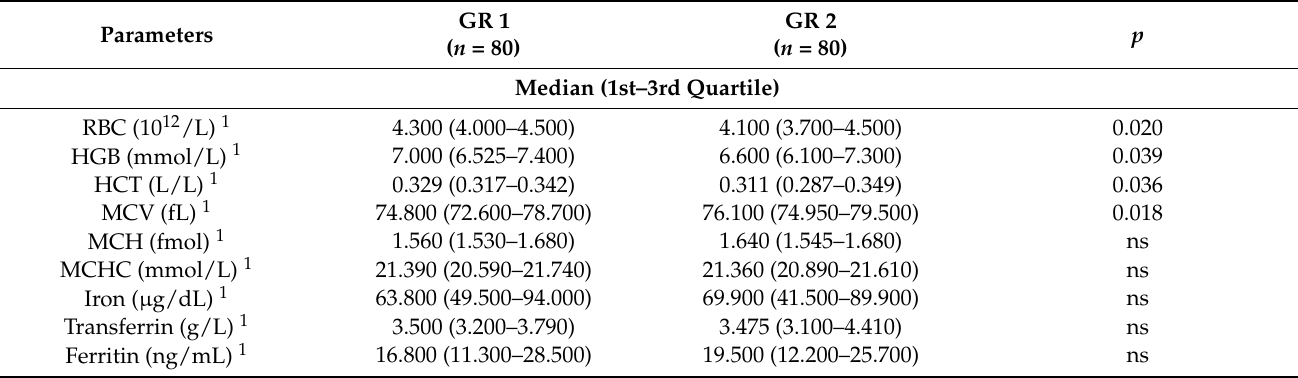
Table 4. Comparison of anaemia-related parameters between the study groups at the end of the trial-end versus